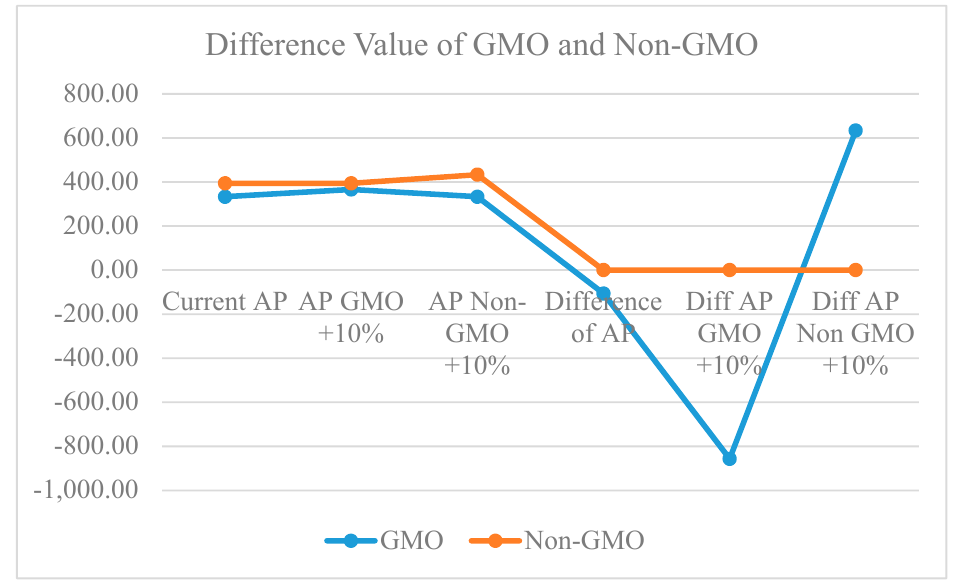
Figure 2. Difference value of GMO and Non-GMO.